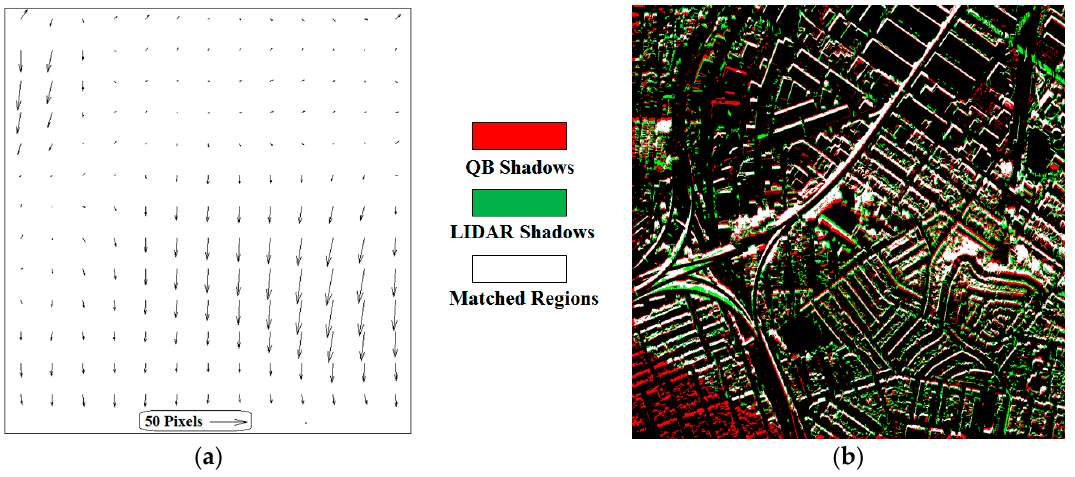
Figure 16. Displacement vectors obtained from the fine 2D model and the result of the matching between the ISM and STLAM: ( a ) 2D Displacements Map; ( b ) Compliance of the STLSM and ISM. Correction vectors ( Δ r, Δ c) were computed for a regular grid of points in PTLSM. For this reason the